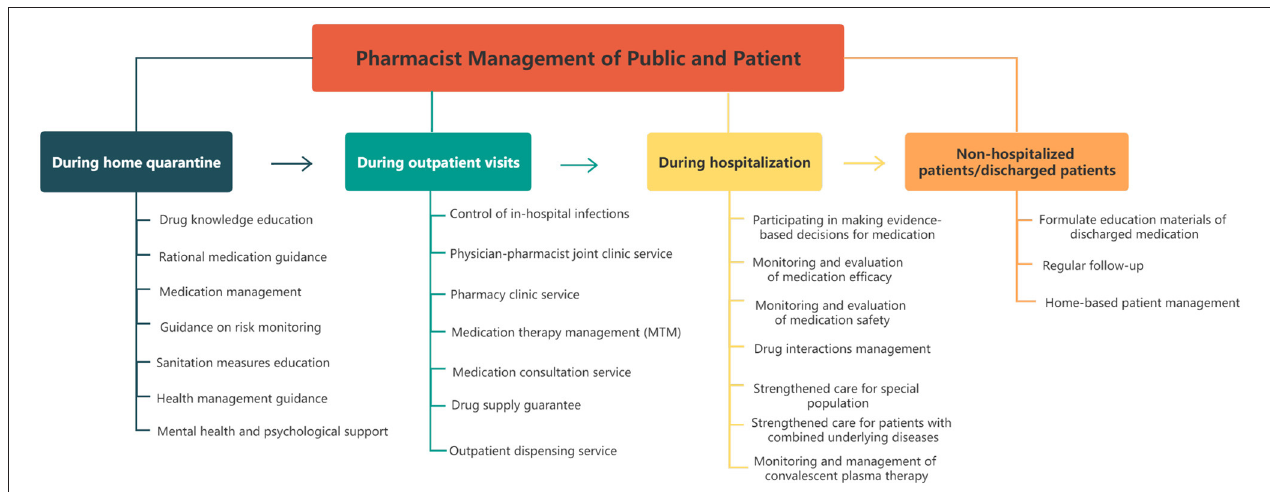
FIGURE 4 | Strategy of pharmacist management of the public and patients during the COVID-19 pandemic.